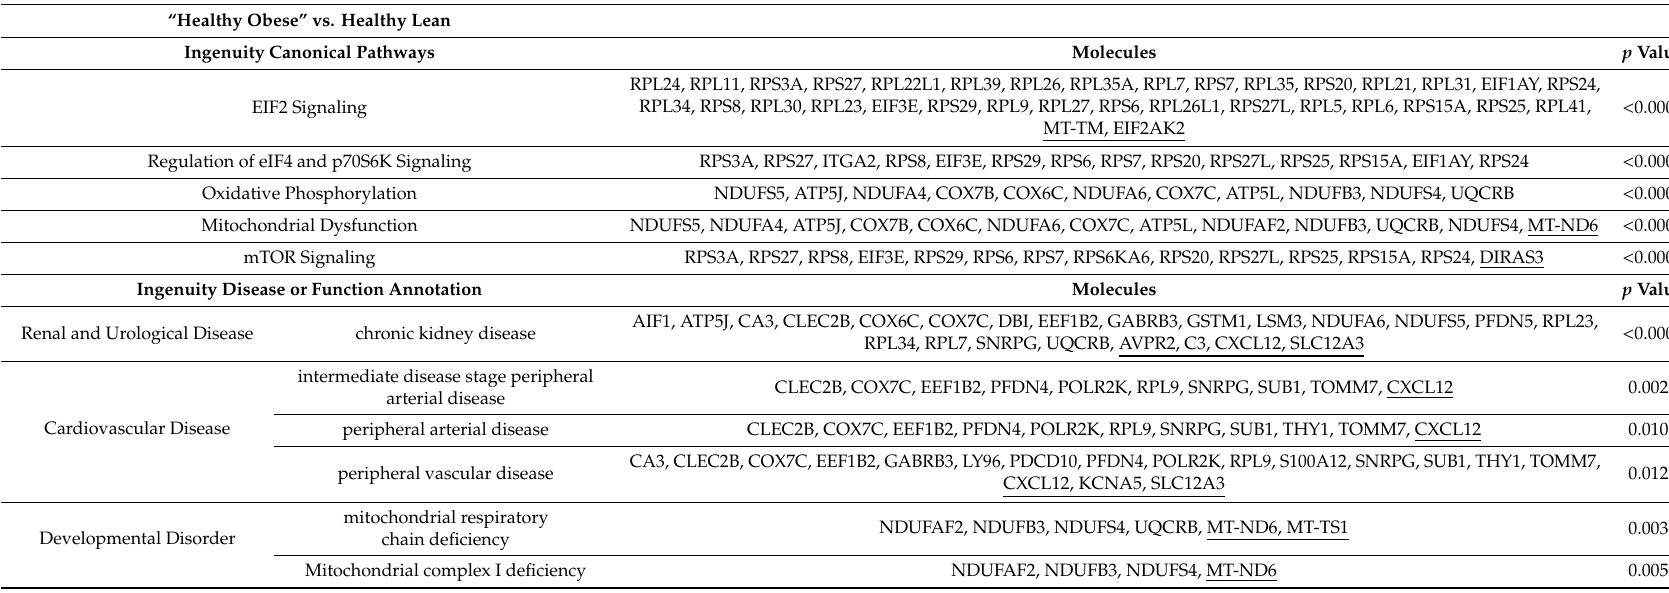
Table 5. Enrichment in Ingenuity Canonical Pathways and Diseases or Functions Annotations among genes di ff erentially expressed between “healthy obese” and healthy lean individuals, where the majority of genes within each pathway are up-regulated. Down-regulated genes are underlined. “Healthy Obese” vs. Healthy